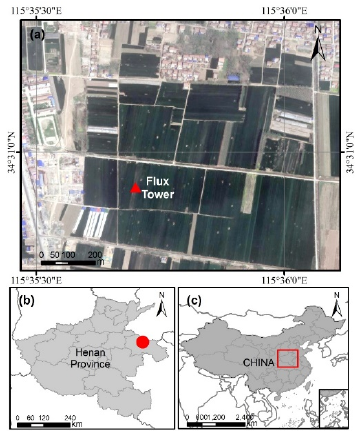
Figure 1. Location of the study site at Shangqiu station, Henan province, China. Panel ( a ) was a satellite image of the maize field in our study area from Google Earth. ( b ) and ( c ) represented the location of the study site in Henan province and China,